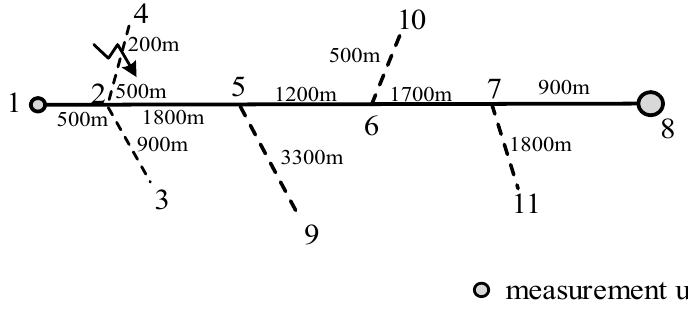
Figure 3. A branch network with two measurement units.